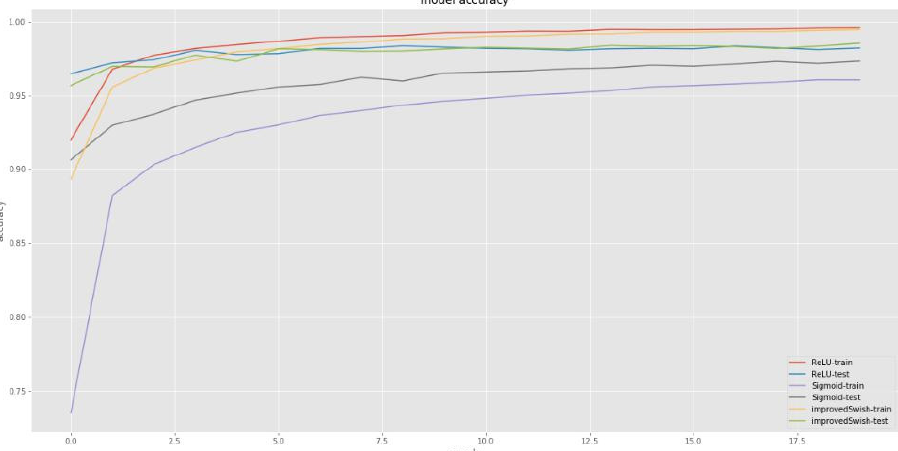
Figure 2. Comparison of accuracy. The horizontal axis represents epoch times (0~17.5), and the vertical axis represents accuracy value (0.7~1).